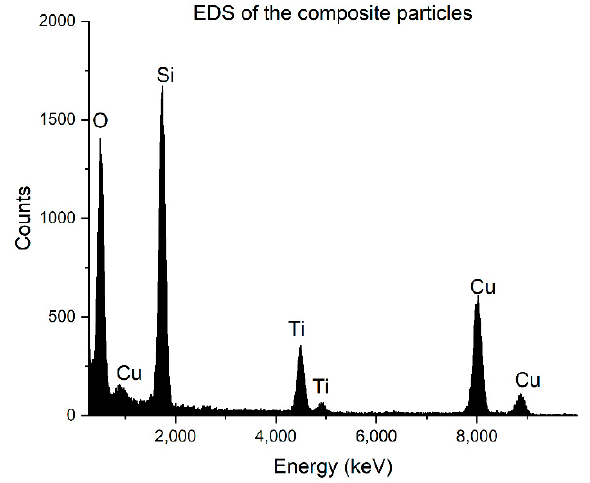
Figure 4. EDS of the composite particles.